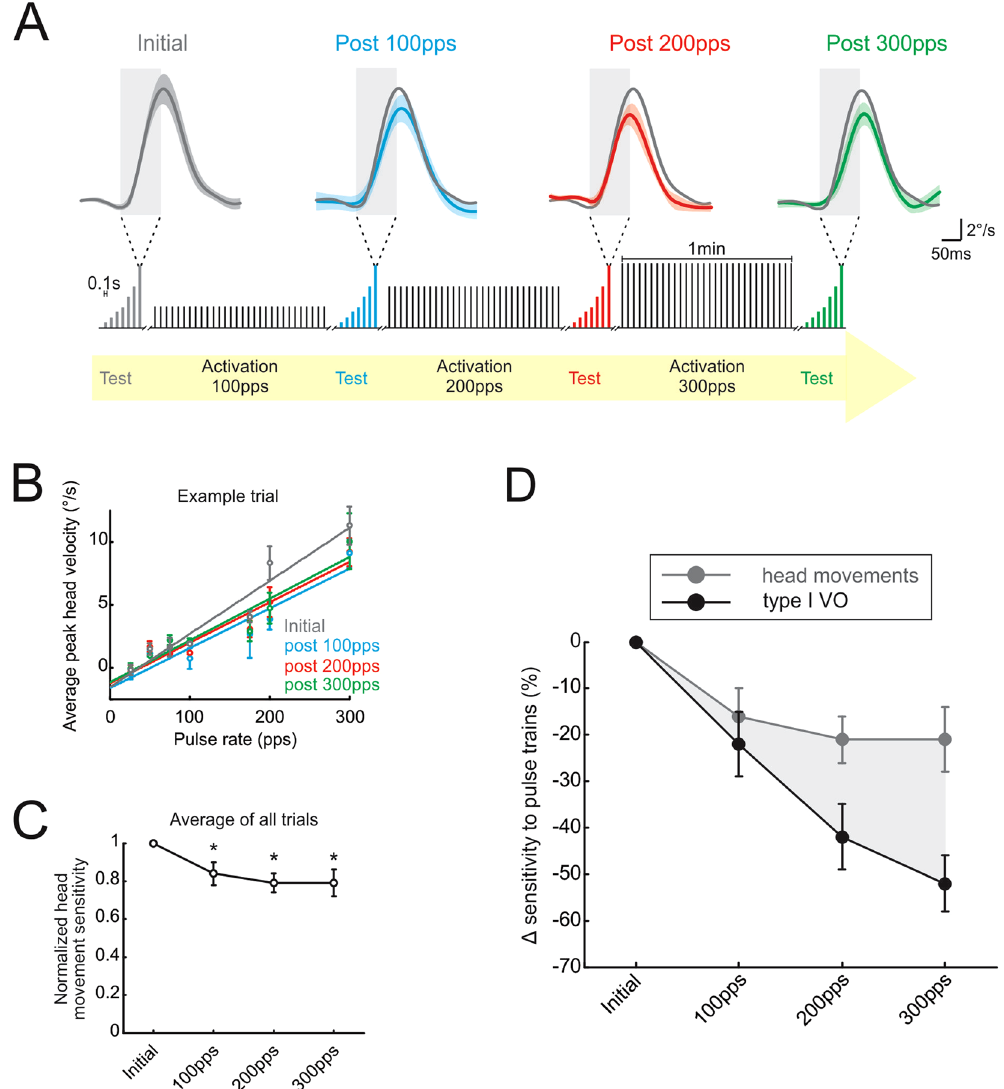
Figure 4. Activation of vestibular nerve decreases magnitude of vestibularly-driven head movements. ( A ) Head movements evoked during test pulse trains of 300pps before and after activation of the vestibular nerve. Inset below shows timeline of stimulation protocol. ( B ) Peak head velocity versus pulse rate during test stimuli before and after activation of the vestibular nerve. ( C ) Head movement sensitivity decreases following activation of the vestibular nerve. ( D ) Comparison between attenuation in head movement and neural sensitivity to test stimuli for type I VO neurons. Error bars and shaded area represent ±